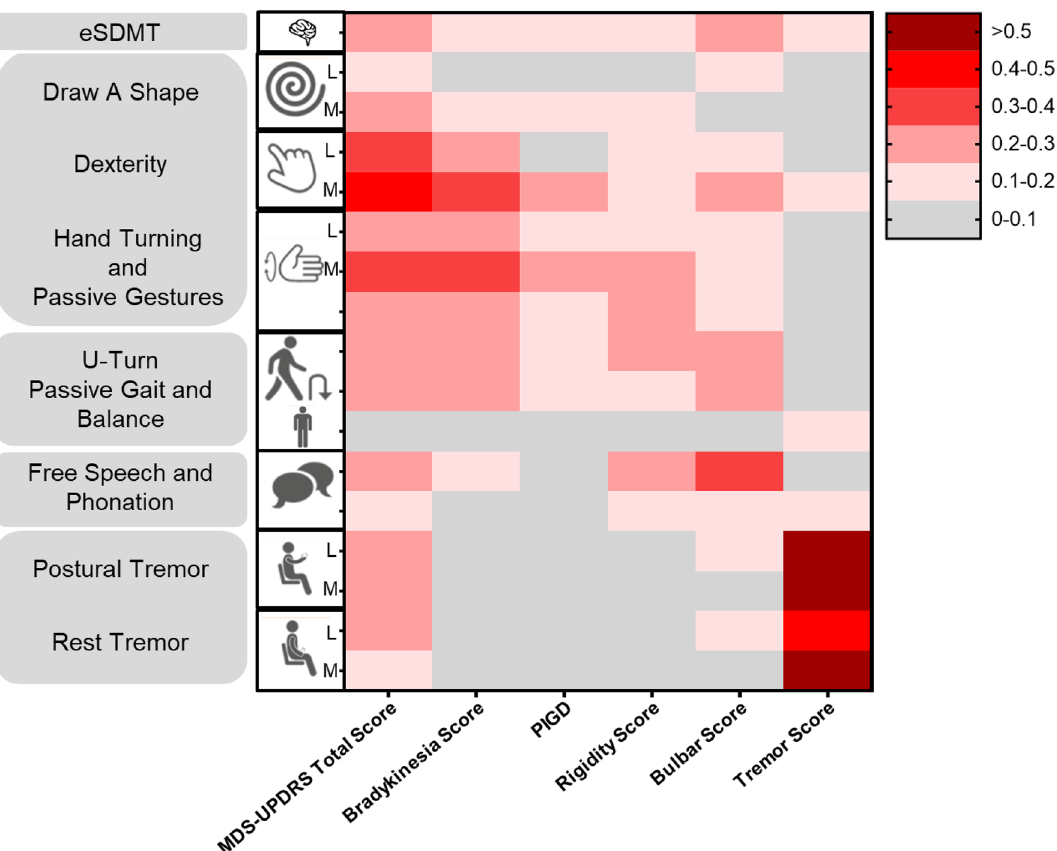
Figure 2. Absolute Spearman’s correlations between baseline MDS-UPDRS Total and Subscores and Roche PD Mobile Application v2 active test and passive monitoring sensor features. eSDMT electronic Symbol